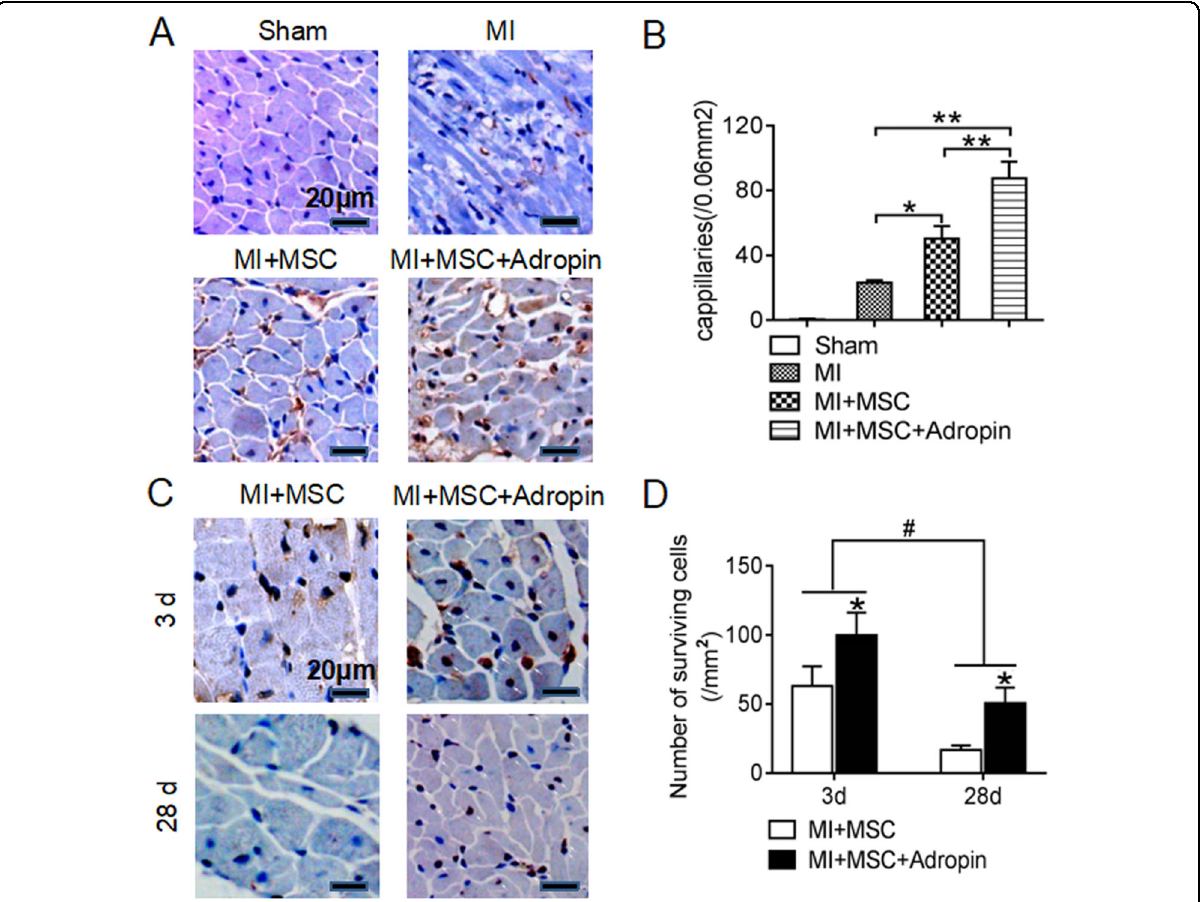
Fig. 5 Increased neovascularization and number of surviving transplanted MSCs by adropin-based dual treatment in rat myocardial infarction. Immunohistochemical staining was performed to detect neovascularization and surviving implanted MSCs. A , C The positive staining for factor VIII-related antigen and surviving BrdU-positive implanted MSCs were brown by diaminobenzidine (DAB), and the nuclei were counterstained blue by hematoxylin (original ampli fi cation: ×200 in ( A ), ×400 in ( C )). B Adropin-based dual treatment (the MI + MSC + Adropin group) had more neovascularization than MSCs transplantation alone (the MI + MSC group) at day 28 after cell therapy. D Adropin-based dual treatment conferred more surviving implanted MSCs than MSCs transplantation alone at the early (day 3) and late (day 28) stages after cell therapy. MSCs and MI, see Fig. 1. Data are expressed as mean ± SD, n = 8. * p < 0.05 and ** p < 0.01 in ( B ). * p < 0.05 as compared with the MI + MSC group, and # p < 0.05 in ( D